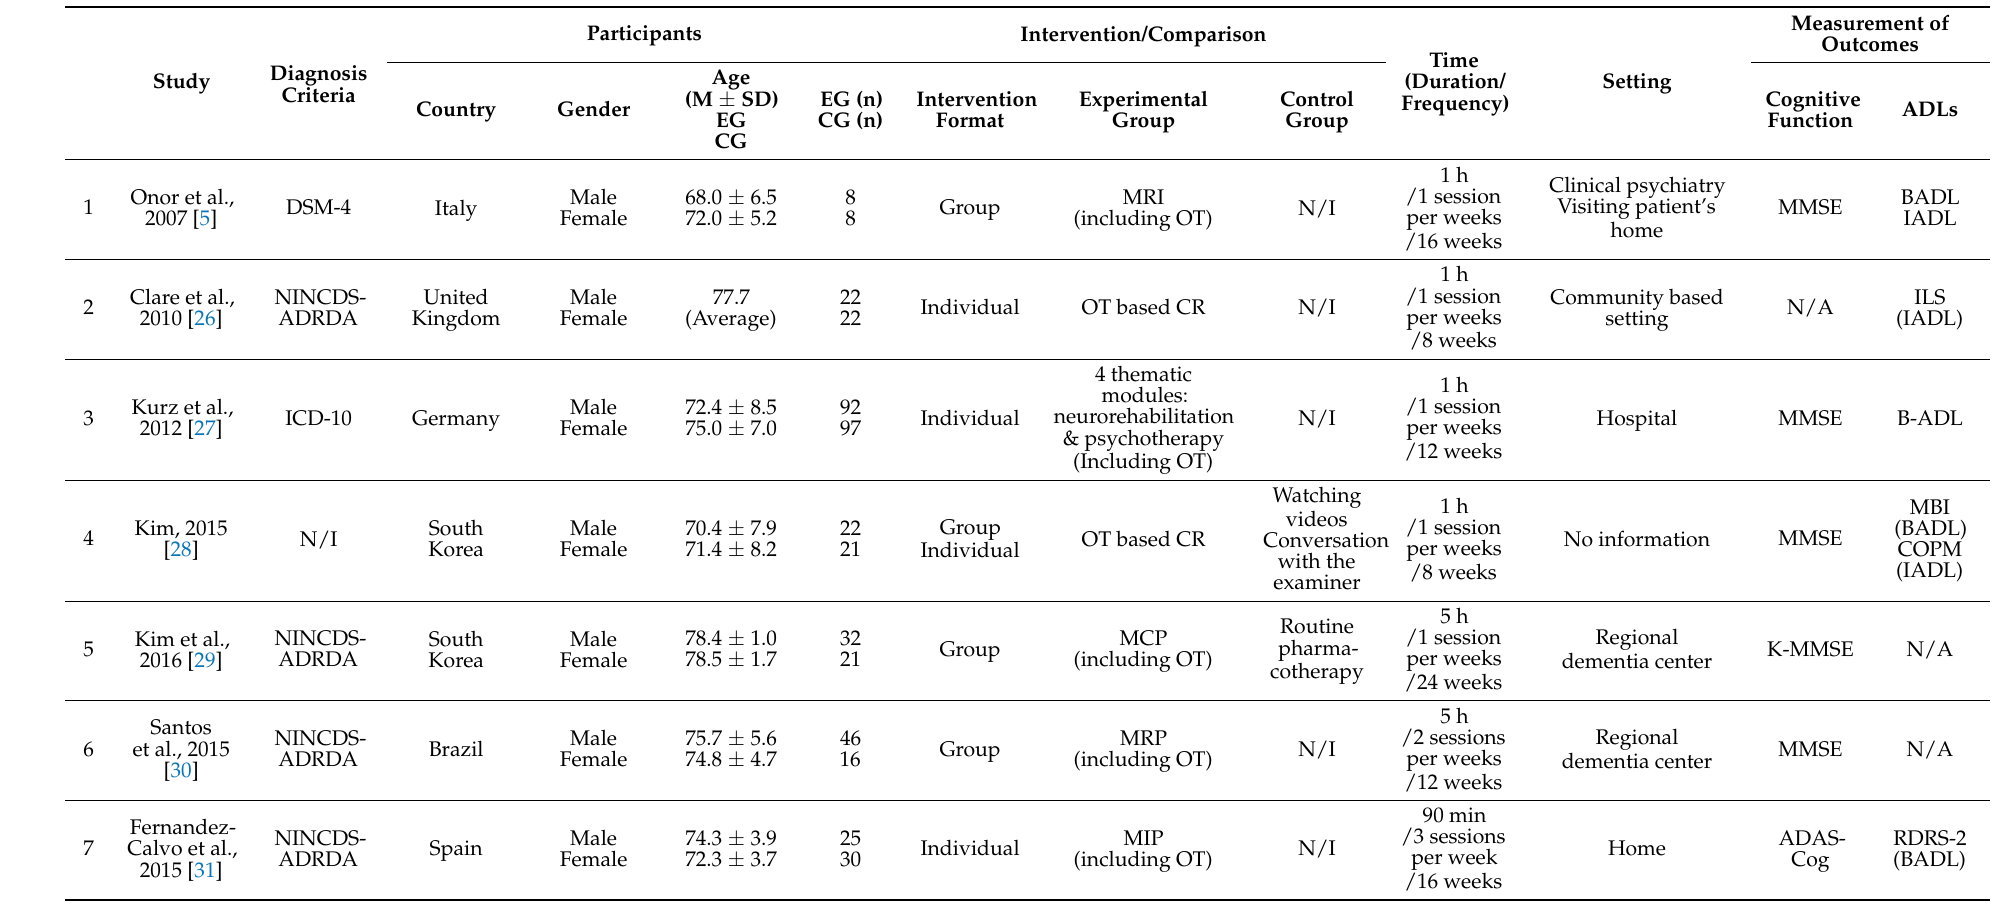
Table 1. Characteristics of included